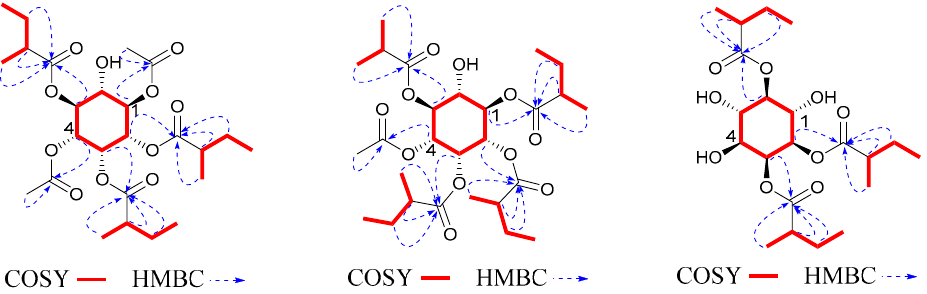
Figure 4. 1 H- 1 H COSY, key HMBC correlations of compounds 3 , 4 , and 5 .